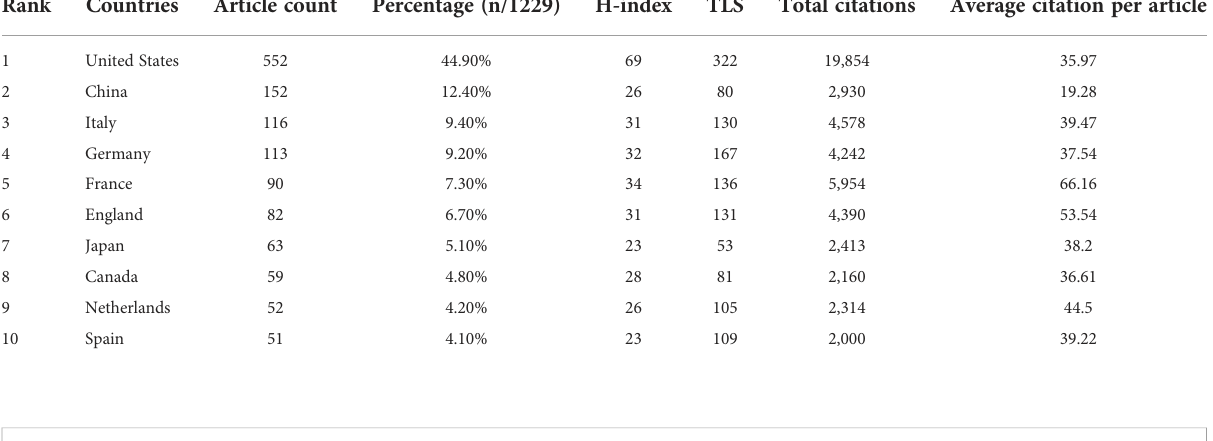
TABLE 1 The top 10 productive countries with publications.